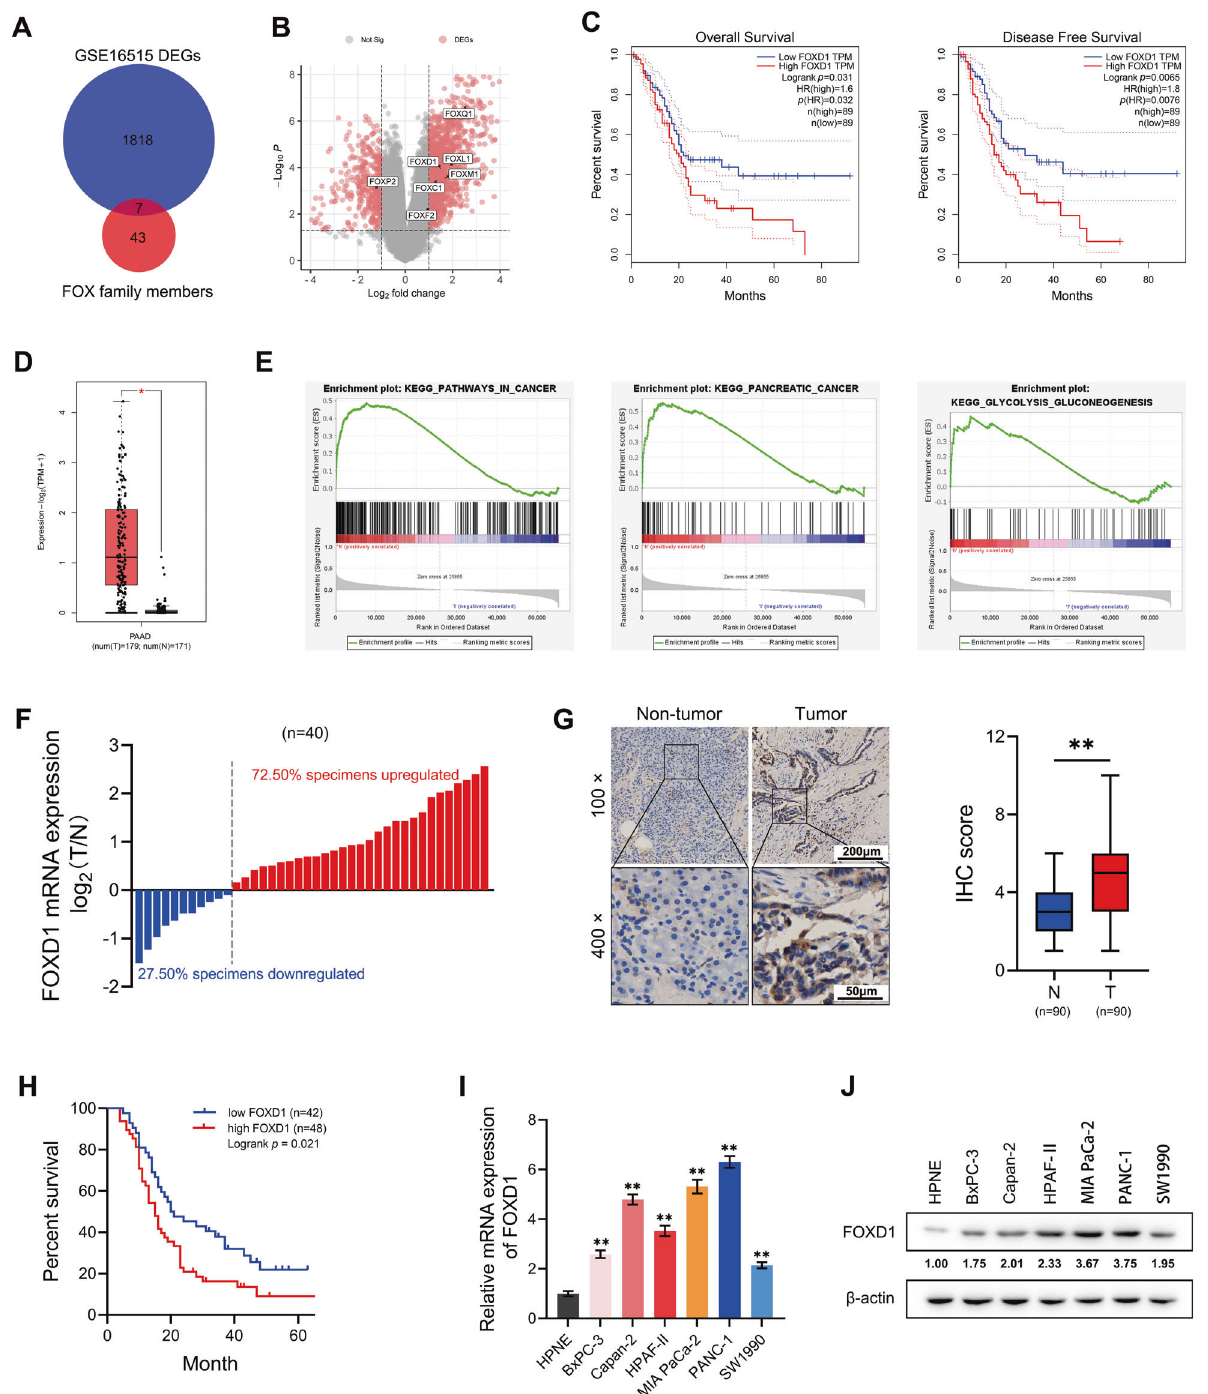
Fig. 1 FOXD1 is overexpressed in PC tissues and cells. A The intersection between differentially expressed genes (DEGs) in GSE16515 and FOX family members, represented as a Venn diagram. B Volcano map of the DEGs in GSE16515. C Overall survival curve and disease-free survival curve of FOXD1 differentially expressed PC patients based on TCGA database. D Relative expression of FOXD1 in 179 PC(T) tissues and 171 non-tumor (N) tissues based on TCGA and GTEx database. E GSEA analysis of FOXD1 expression-related genes. F Relative FOXD1 expression in 40 pairs of PC (T) tissues and non-tumor (N) tissues detected by RT-qPCR. G Relative FOXD1 expression in 90 pairs PC (T) tissues and non-tumor (N) tissues detected by immunohistochemistry (IHC). H Overall survival curve of 90 PC patients classi fi ed by IHC score. I Relative FOXD1 expression in HPNE cells and PC cells detect by RT-qPCR. J Relative FOXD1 expression in HPNE cells and PC cells detect by western blotting analysis. * p < 0.05; ** p < 0.01.